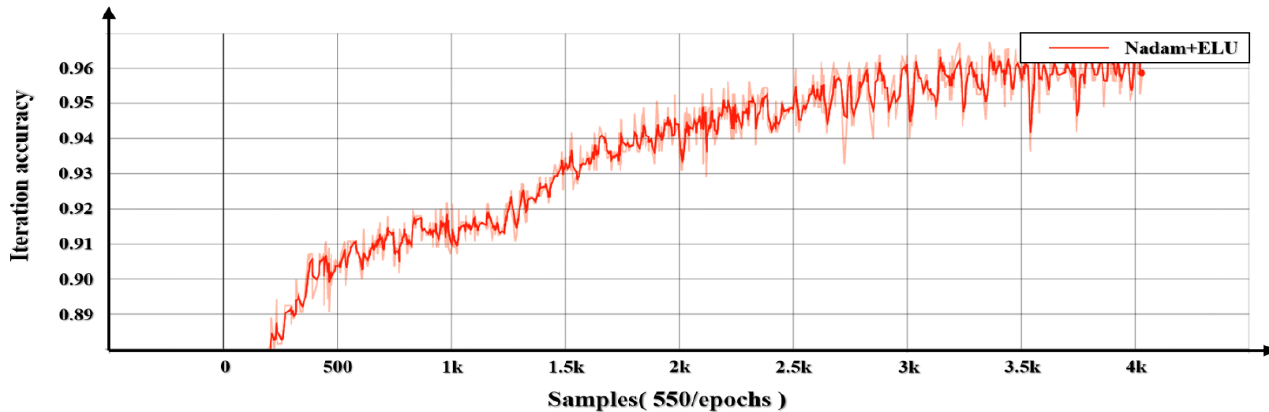
Figure 15. The precision for the solution of Nadam+ELU.